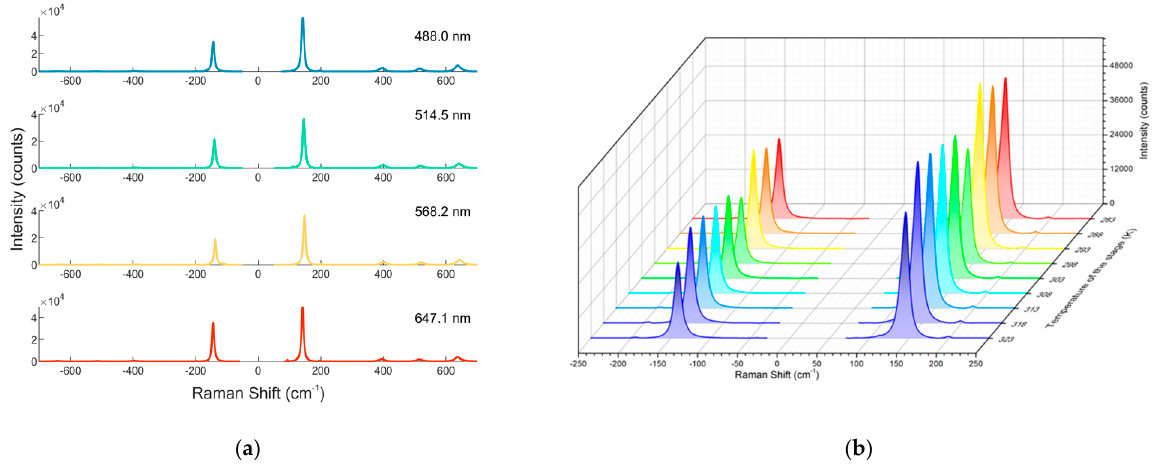
Figure 4. ( a ) Experimental anti-Stokes and Stokes spectra of TiO2 collected at room temperature and different excitation wavelengths (488.0 nm blue line, 514.5 nm green line, 568.2 nm yellow line and 647.1 nm red line); ( b ) Stokes and anti- Stokes spectra of the 143 cm − 1 E g mode, collected at 488.0 nm as function of temperature (from 283 to 323 K, with 5 K increment step).